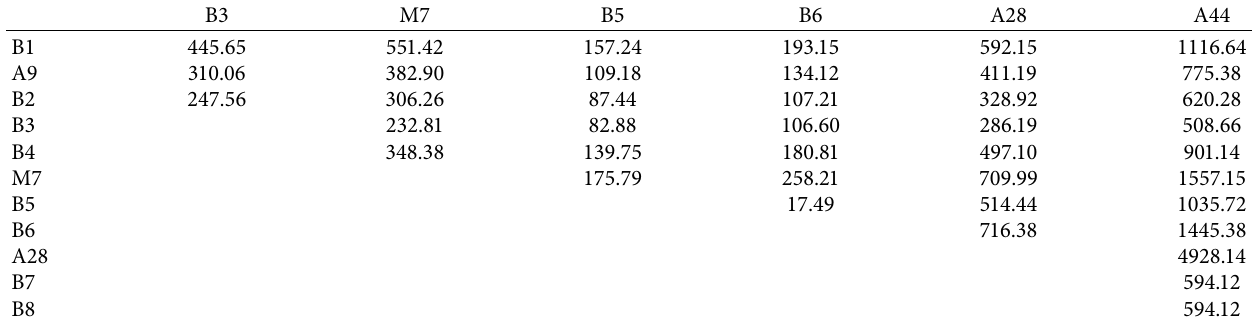
Figure 2: Sydney’s M4 Motorway. Table 4: Total demand.